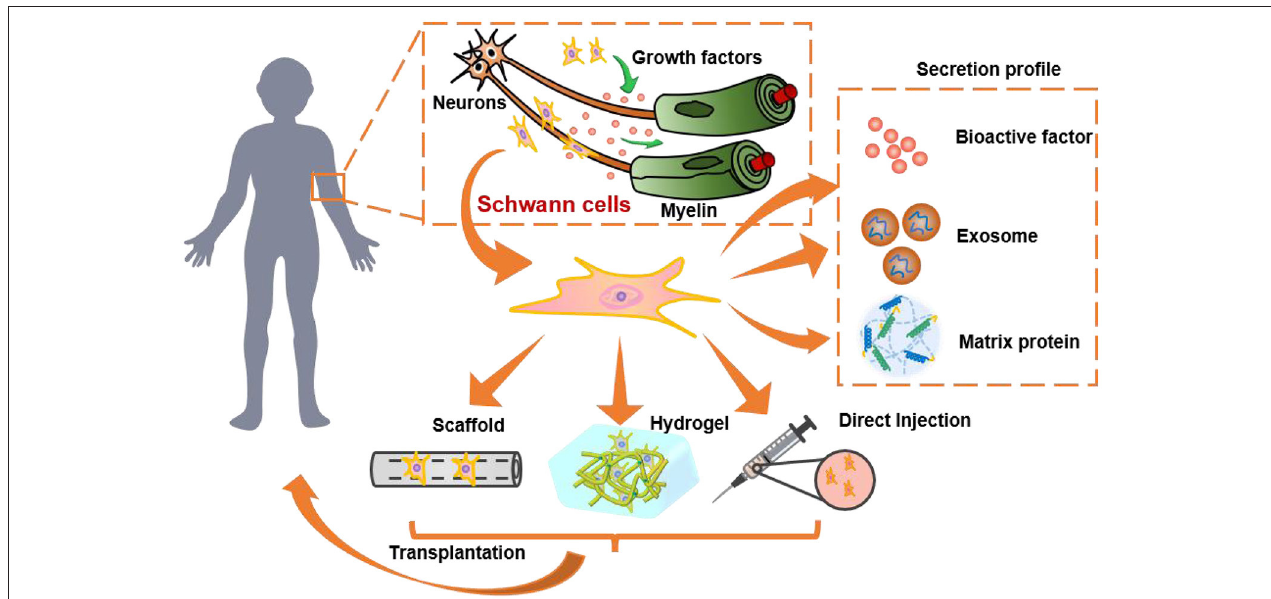
FIGURE 1 | The role and of SCs and SC-derived materials in nervous system and their transplantation for nerve regeneration. SCs secret growth factors to protect neurons, promote neurite growth, and wrap around axons to form myelin. They can be transplanted by direct injection into humans or pre-encapsulated in 3D hydrogels/scaffolds for transplantation. Besides, the secretion profile of SCs, such as the bioactive factors, exosomes, and extracellular matrix proteins, are also promising alternatives to SCs